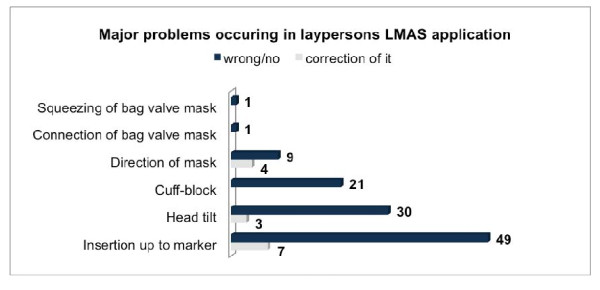
Number and origin of errors and individual correction. Data are numbers.